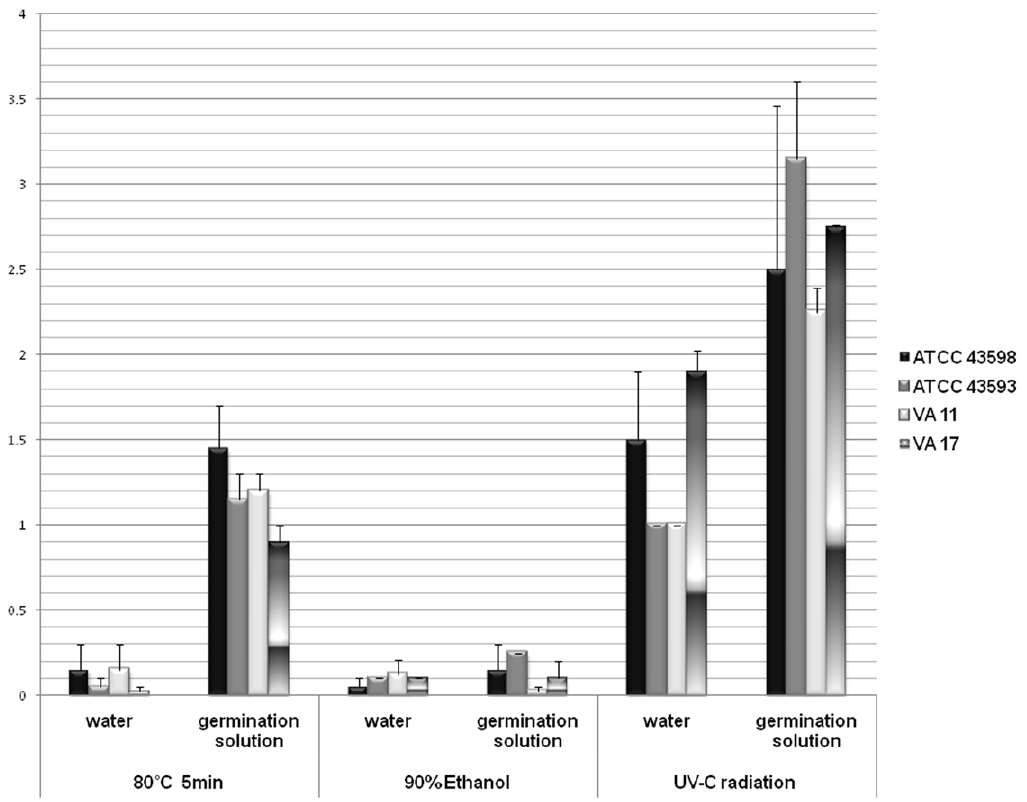
Figure 2. Examination of susceptibility of germinating and dormant spores to ultraviolet-C radiation, heat, and ethanol. Spores of the four experimental strains were incubated in either sterile deionized water or germination solution under ambient conditions for five minutes (confirmed as bright or dark-phase). Spores were exposed to ultraviolet-C (UV-C) radiation (12,000 m Ws/cm 2 ), heat (5 minutes at 80 u C), or 90% ethanol. Mean reduction (log 10 colony-forming units) in viable spores was assessed by enumerating serially diluted plate cultures before and after exposure to UV-C, heat and ethanol.